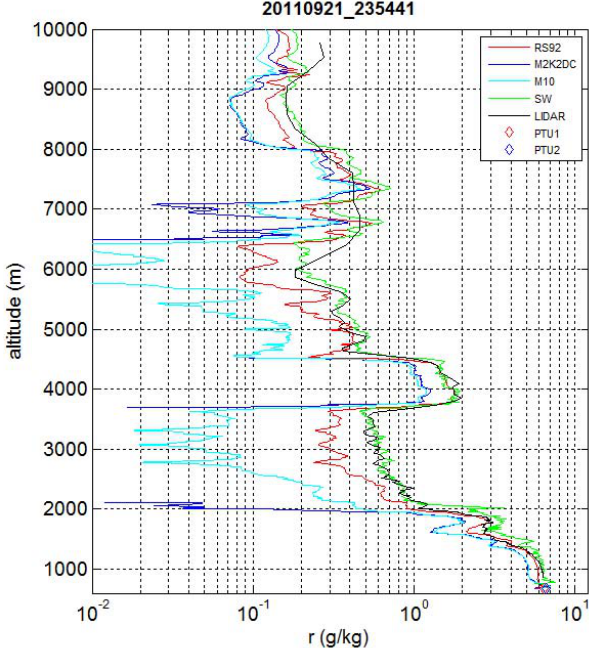
Fig. 14. Similar to Fig. 13 but for sounding on 21 September 2011 at 23:54UTC. Lidar profile is integrated from 23:55 to